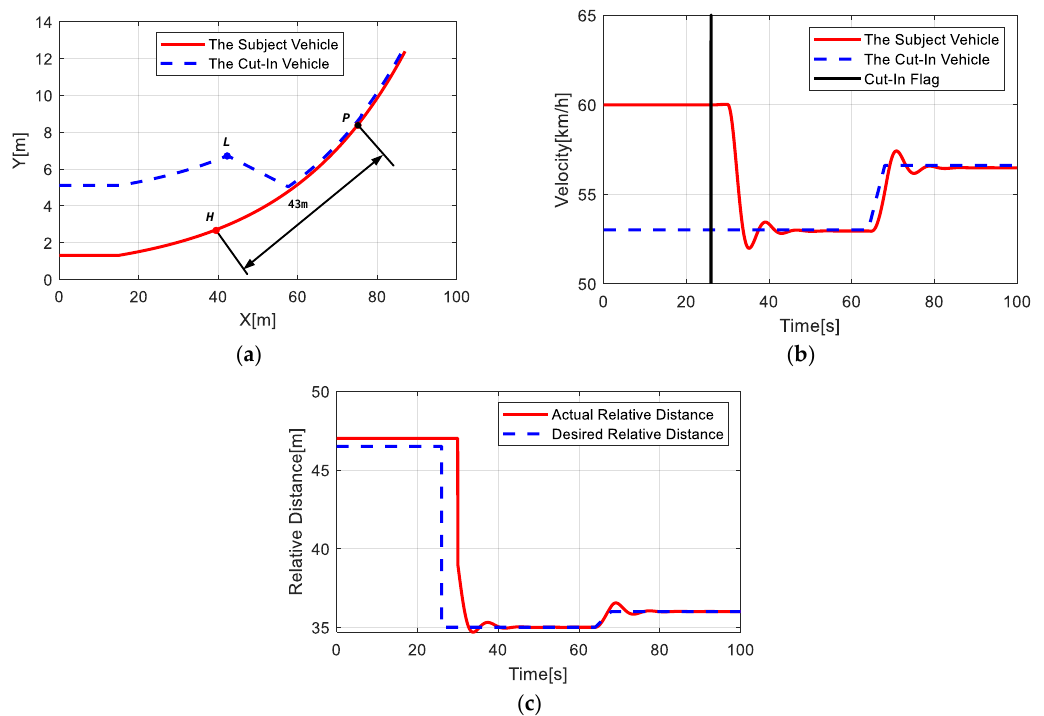
Figure 15. The simulation results of driving scenario 2: ( a ) vehicle positions of cut-in beyond safe distance; ( b ) the velocity of the subject vehicle and the cut-in vehicle; ( c ) the relative distance between vehicles.